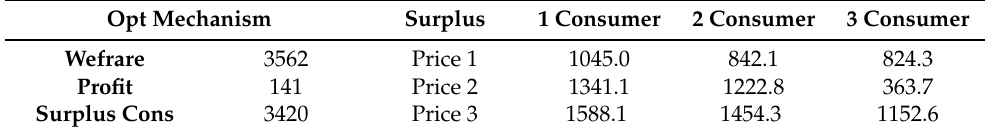
Table 4. Characteristics of the maximum welfare solution for three